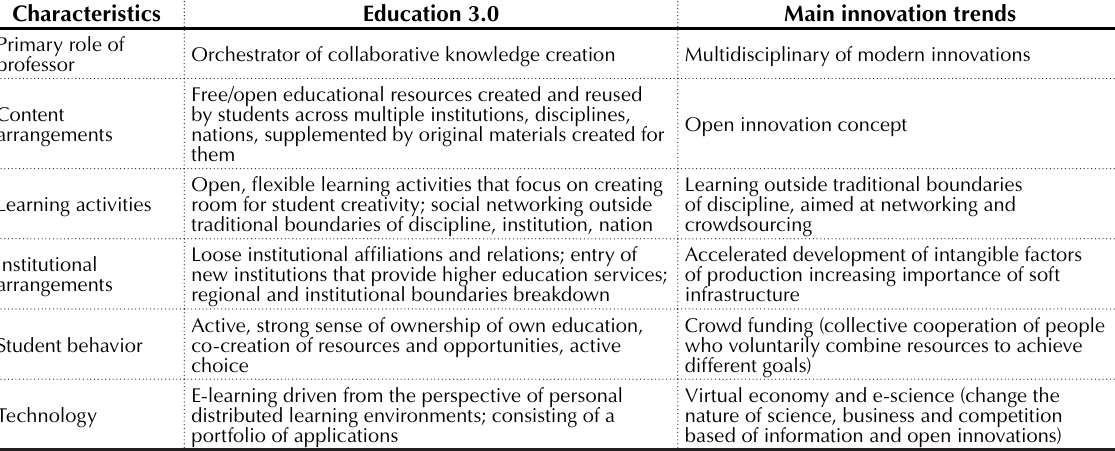
Table 1. Educational generations in higher education and connection of Education 3.0 with the main innovation